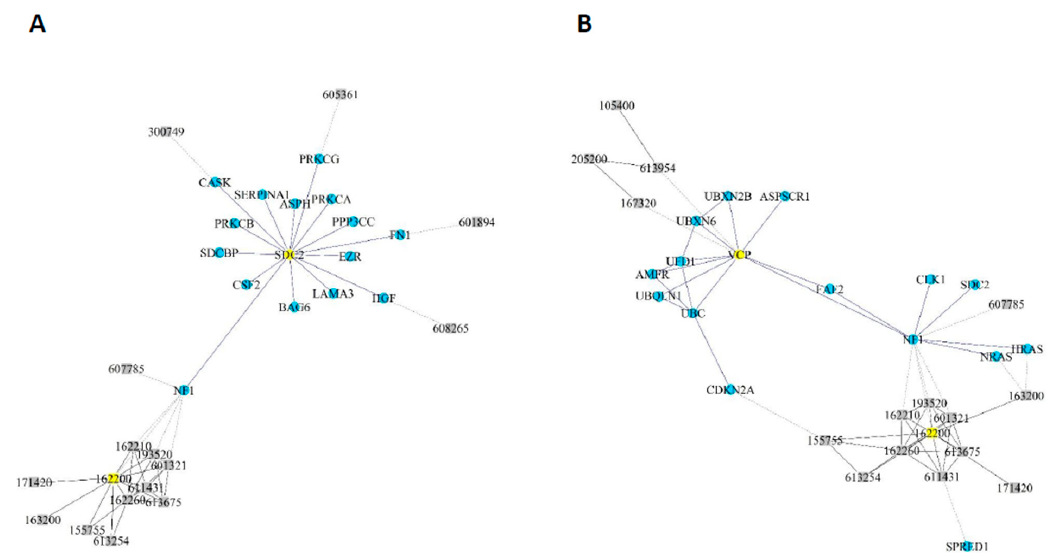
Figure 5. Random walk analysis. The minimum steps (interactions) between the selected genes (nodes) and the neurofibromatosis 1 phenotype were calculated. Two analyses are shown: ( A ) one for SDC2 ; and ( B ) one for VCP .